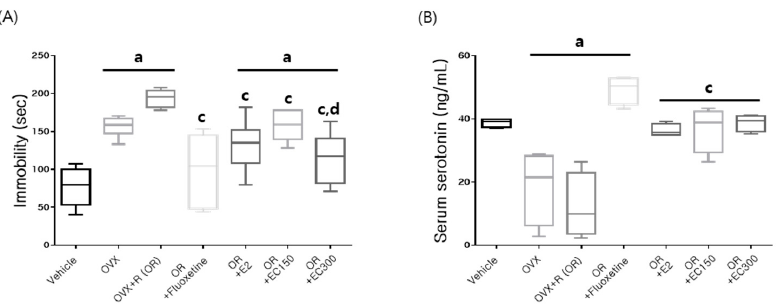
Figure 6. Effects of EC extract on the depressive symptoms and the serum serotonin level in an ovariectomized and restraint-stressed mice model. ( A ) Immobility time in forced swimming test; ( B ) the level of serum serotonin in the mouse model. a p < 0.05 vs. vehicle group. b p < 0.05 vs. OVX. c p < 0.05 vs. OVX + R. d p < 0.05 vs. OVX + R + EC150.